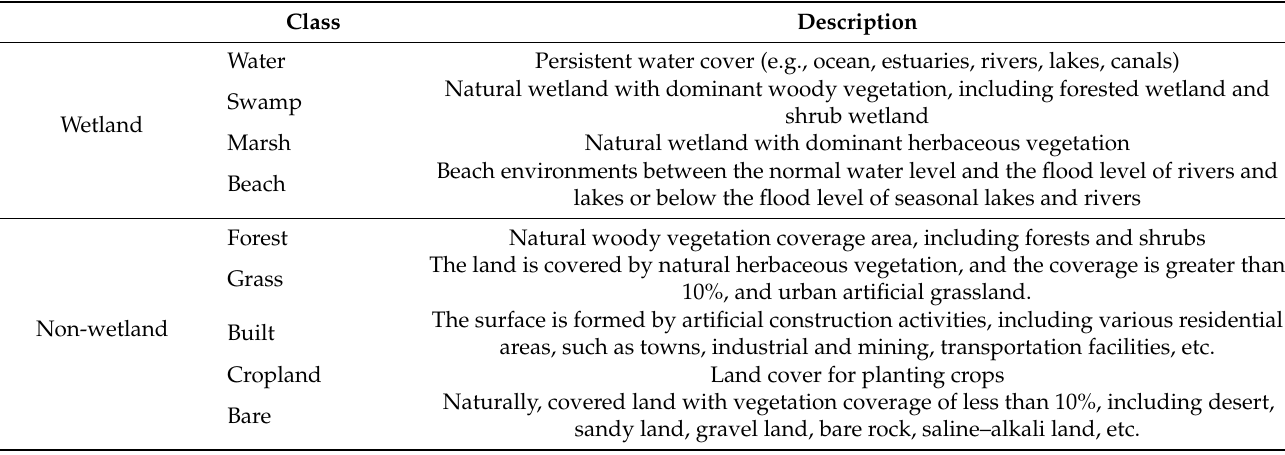
Table 3. Land cover classification scheme for wetland cities.